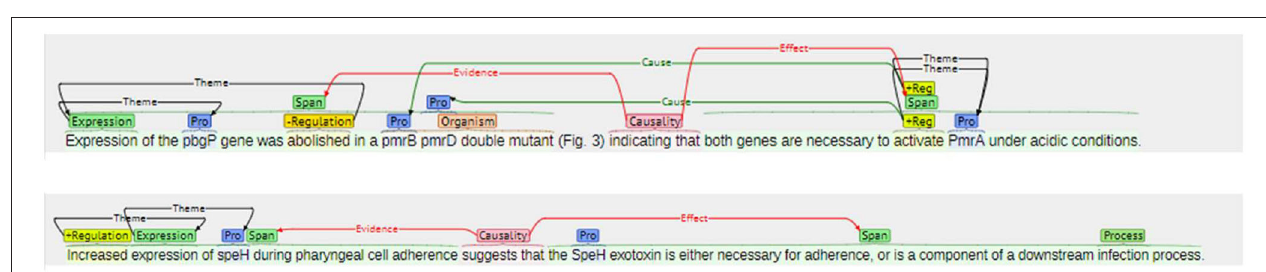
FIGURE 4 | BioCause annotation